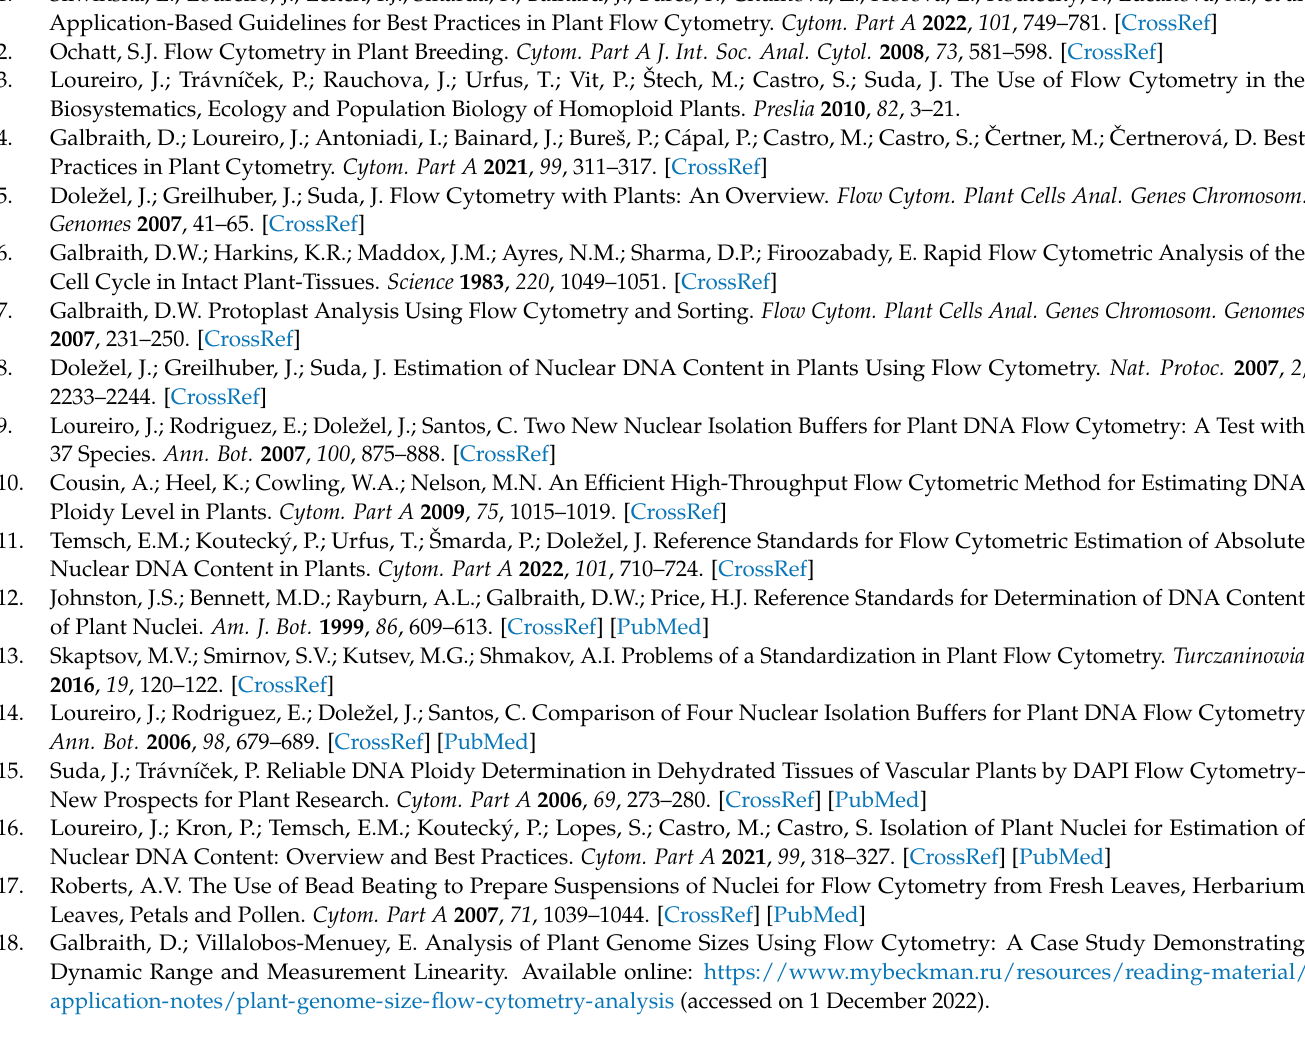
Table S4: Galbraith buffer; Table S5: Tris-MgCl2 buffer; Table S6: A variant of complete lysis